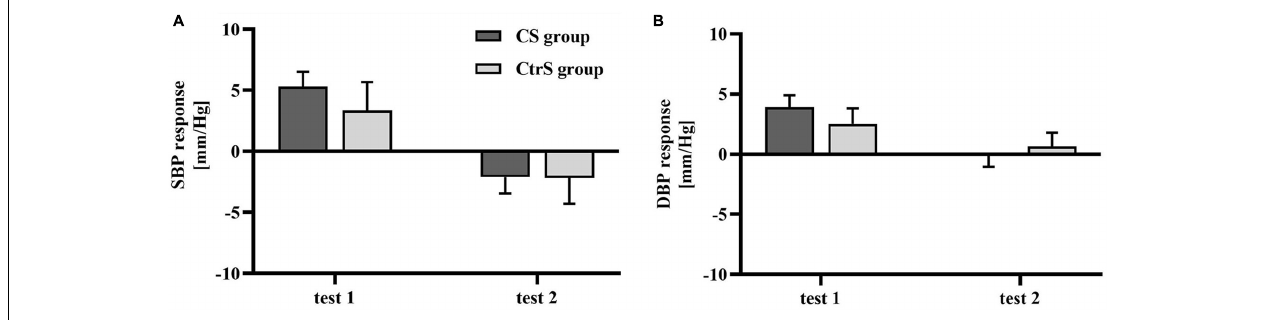
FIGURE 5 | Cue-induced cardiovascular changes within two cue reactivity tests for the CS group and CtrS group. (A) SBP changes. SBP responses in both groups were significantly lower than those before intervention. (B) DBP changes. DBP responses in both groups were significantly lower than those before